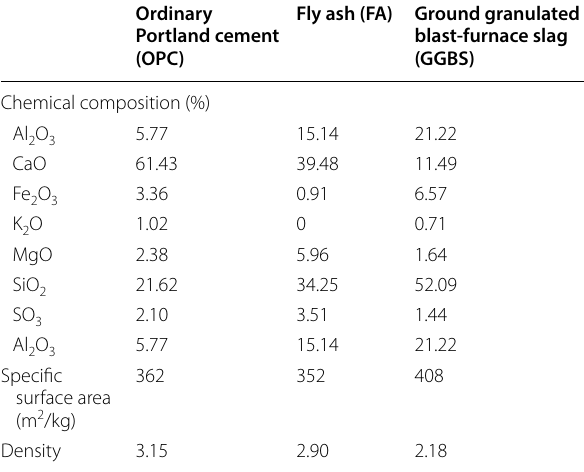
Table 1 Properties of aggregates. Table 2 Chemical compositions and physical properties of cement and pozzolanic